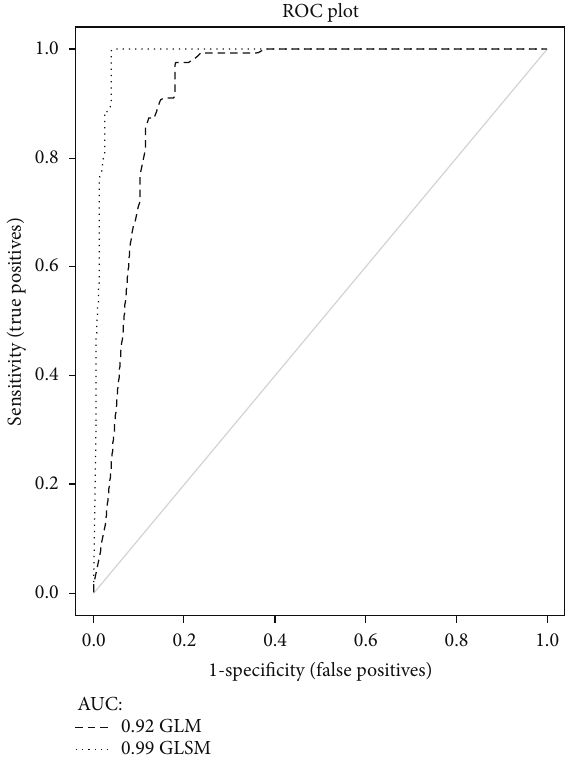
Figure5:ROCcurvesandcorrespondingAUCvaluesforthebinary GLM2 and the